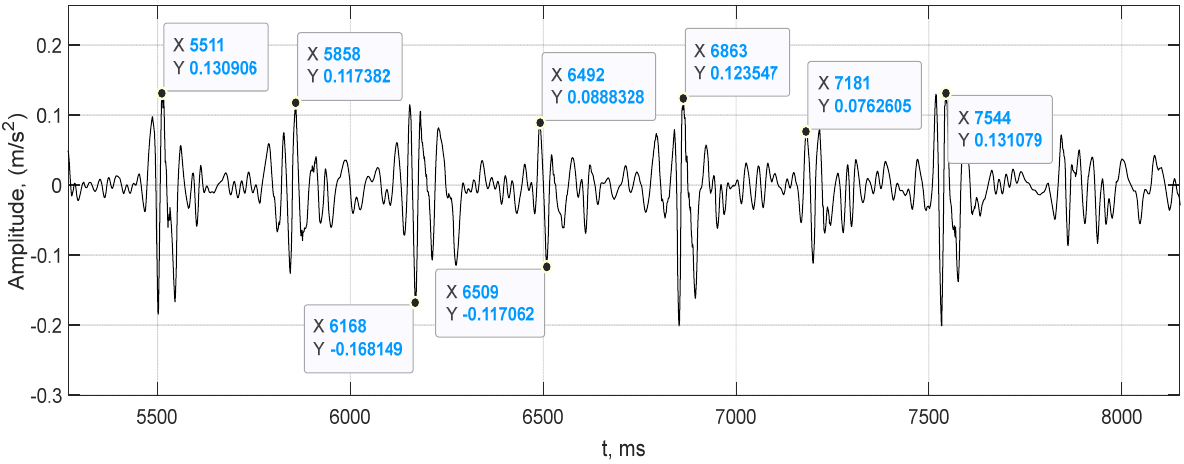
Figure 10. Denoised SCG signal in the second adaptive filter output after individual adjustment. Figure 11 presents the same signal power frequency density, where one can see the extremums of signal amplitude and artifacts sequences. White spaces indicates each HR cycle signal peaks maximum power in